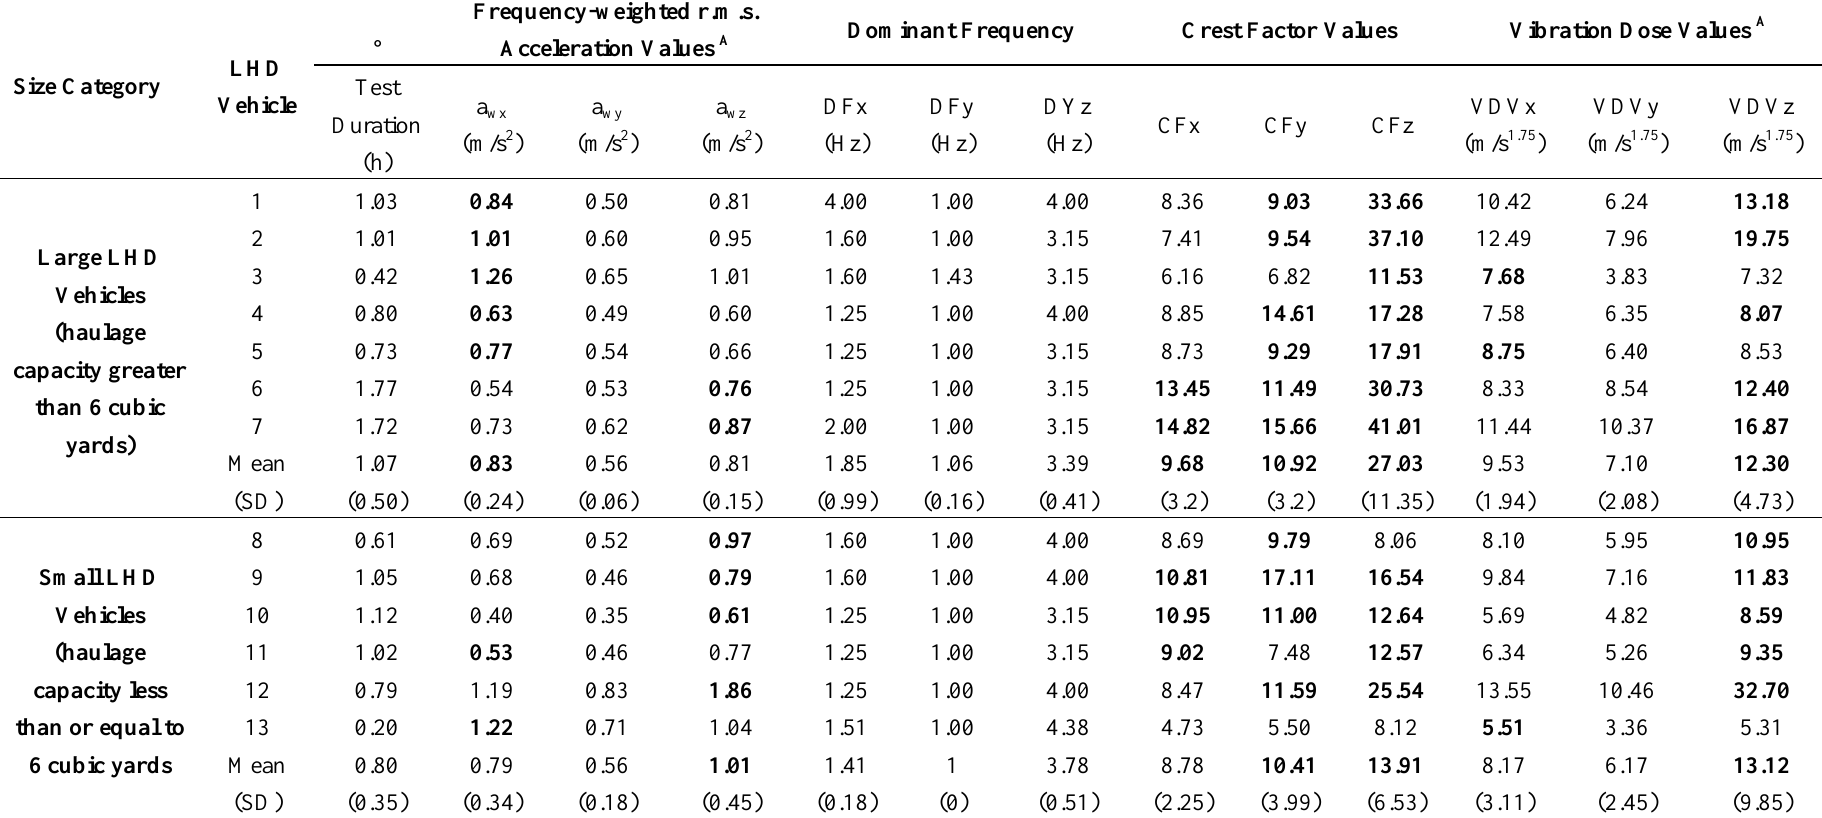
Table 2. Summary of vibration information measured at the operator/seat interface during LHD vehicle